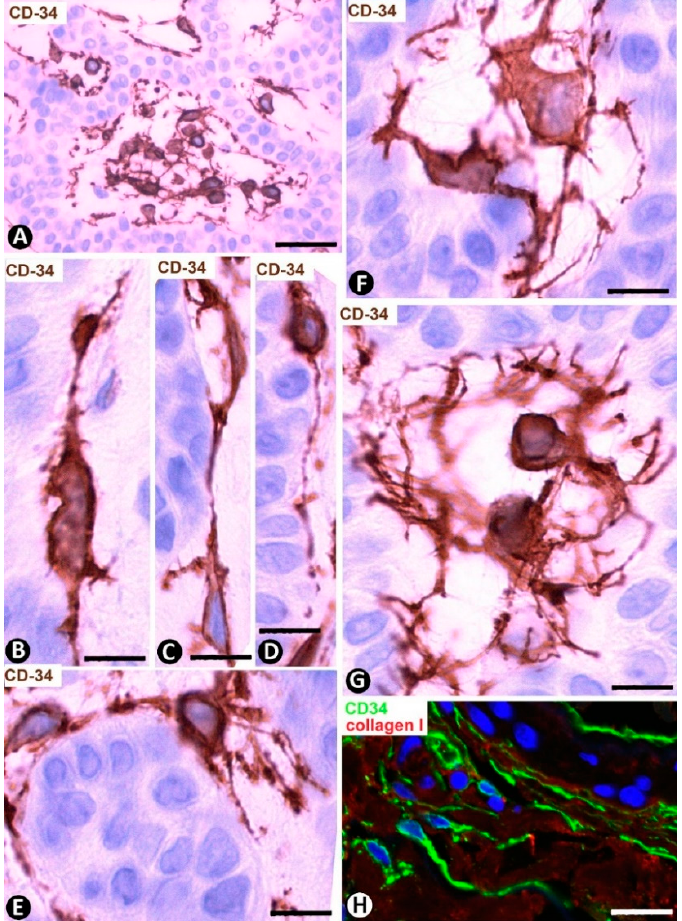
Figure 15. CD34+SCs/TCs in the stroma of trichoepithelioma. ( A – G ) CD34 immunochemistry; hematoxylin counterstain. ( H ): Double immunofluorescence labelling for CD34 (green) and Collagen ( I ) (red). ( A ) CD34+SCs/TCs are observed around the epithelial tracts. ( B – E ) Presence of CD34+ cells attached to the epithelium. Observe that the attached cells tend to acquire a bipolar aspect with long telopodes. ( F , G ) CD34+SCs/TCs with the somatic region located in the interstitium. Note that these cells are usually multipolar with telopodes that extend to the epithelial tracts. ( H ) CD34+SCs/TCs (green) are observed around Collagen I (red). Bar: ( A ) 45 µm, ( B – G ) 15 µm, ( C ) 15 µm, ( H ) 80 µm. CD34+SCs/TCs in the Nevus Sebaceous of Jadassohn